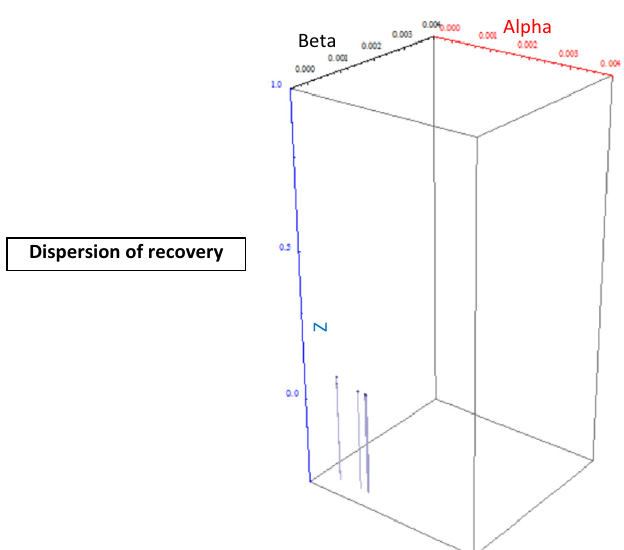
Fig. 8. Spread of the point cloud of noise of measurement and dispersion of